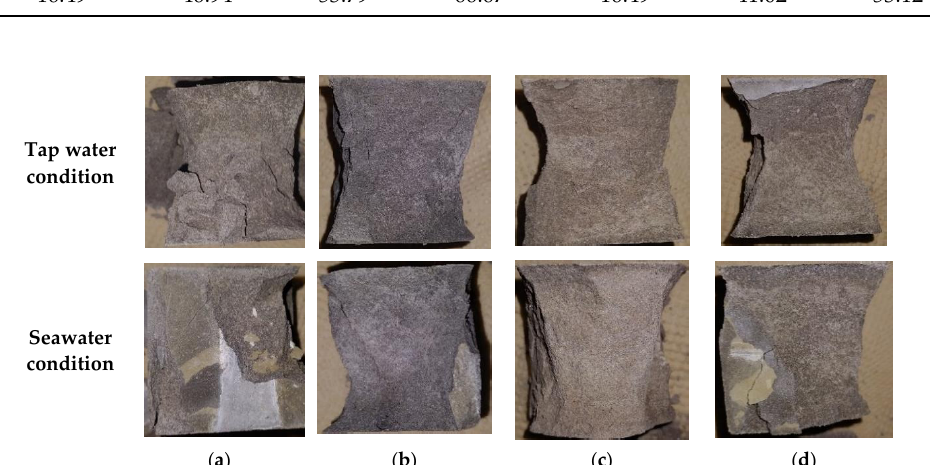
Figure 5. Compressive strength development of samples: ( a ) Measured strength values of samples cured in tap water; ( b ) Measured strength values of samples cured in seawater.